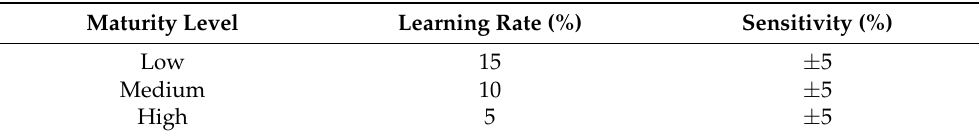
Table 1. Learning rate assumptions applied depending on component and process